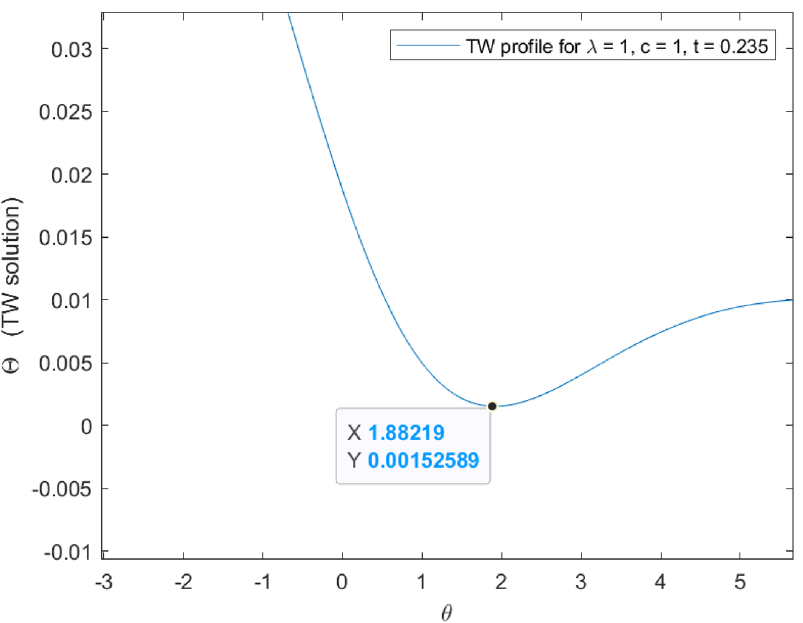
Figure 9. The first minimum is positive in t = 0.235 . For lower or higher t − values the first minimum is